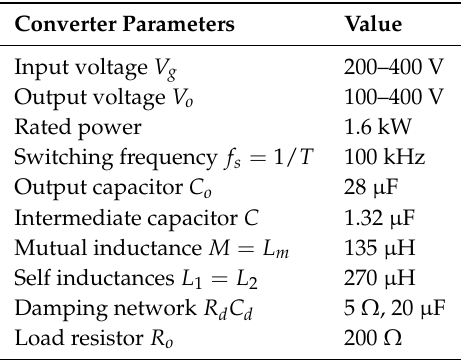
Table 1. Parameters for the buck-boost